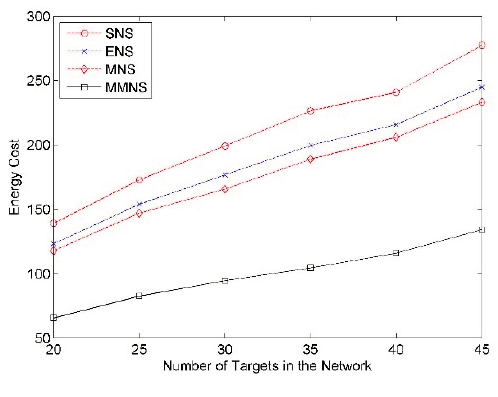
Figure 6. The impact of the number of targets on the energy